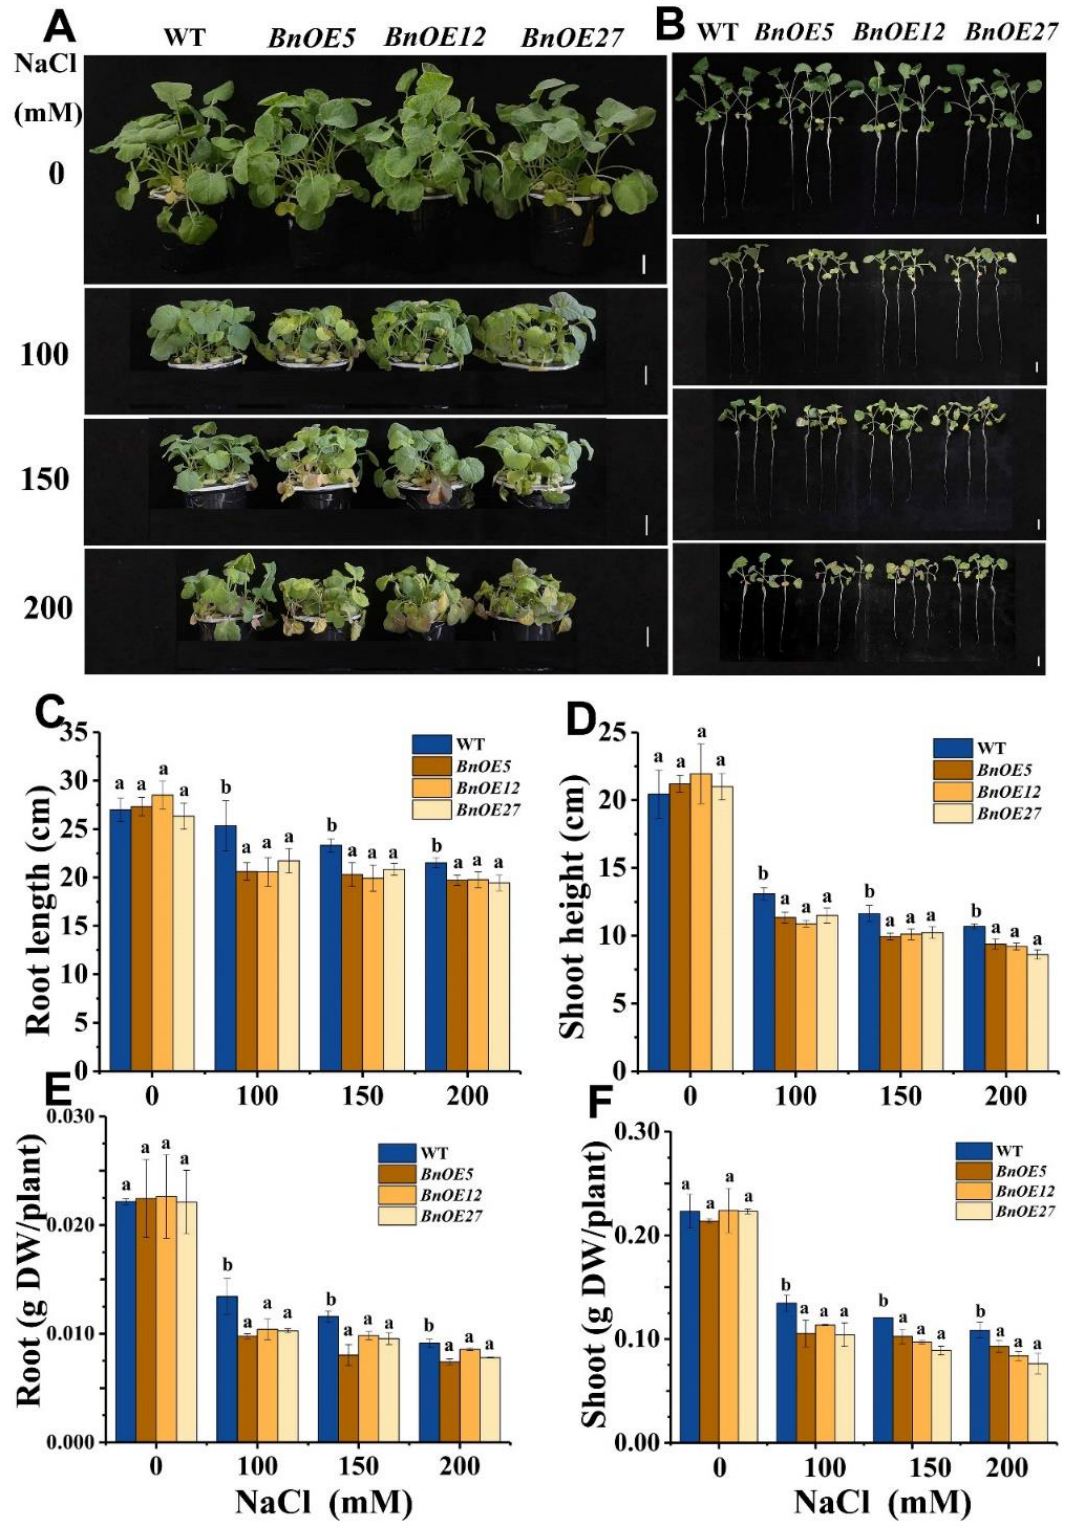
Figure 3. BnRH6 overexpression reduces Brassica plant growth and dry weight under NaCl treatment. ( A , B ): Phenotypes of the transgenic BnRH6-overexpression Brassica ( BnOE ) lines. Scale bars = 3 cm. ( C , D ): Root length and shoot height of BnOE lines. ( E , F ): Root and shoot dry weight of BnOE lines. Ten-day-old wild-type and BnOE plants were treated with NaCl gradient from 75 to 100, 150, and 200 mM. After 14 days, the root length, shoot length, and dry weight were measured. DW: dry weight. Vertical bars represent mean values ± SD (n = 30). Different letters indicate significant differences between three independent experiments (analysis of variance; p < 0.05).